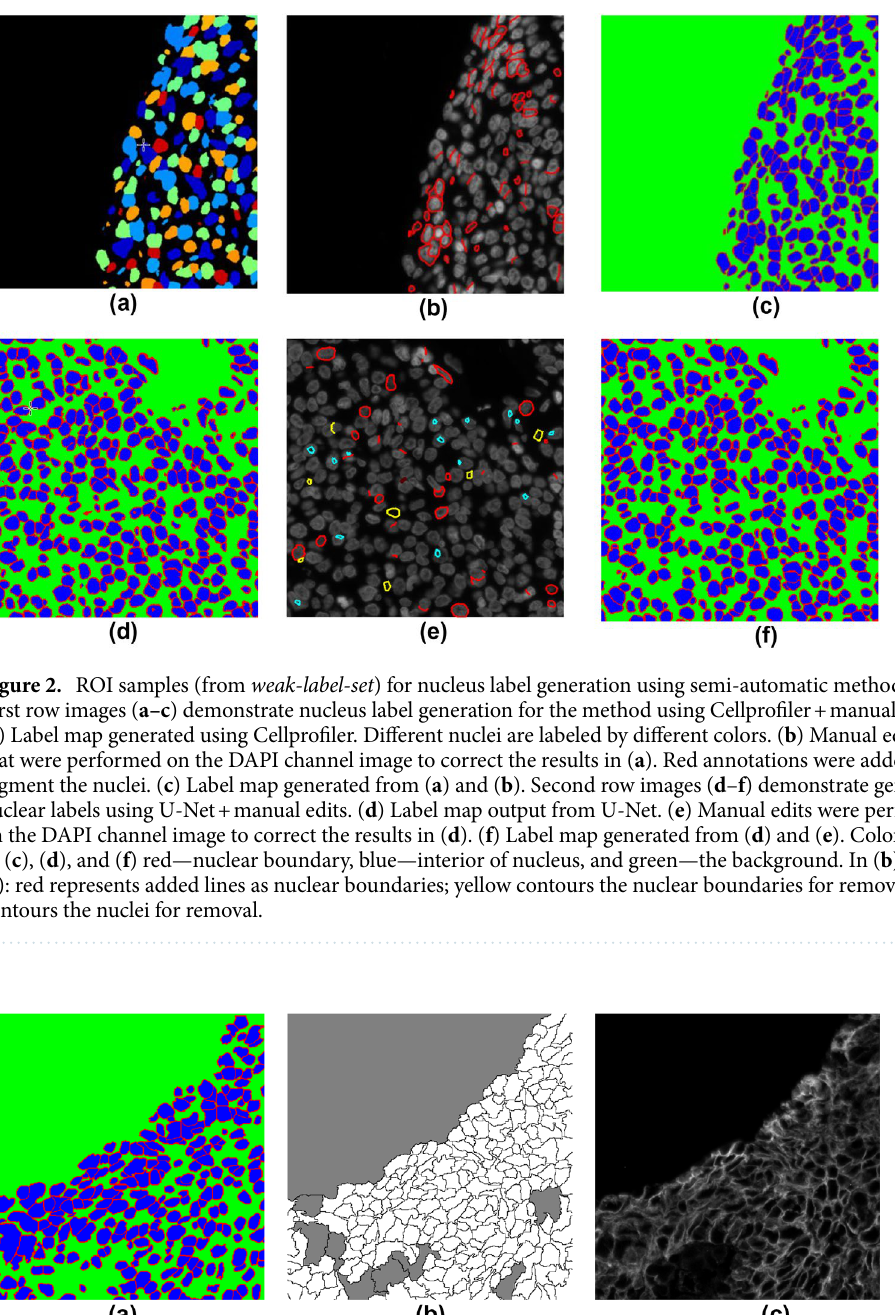
with weak-label-set ; (2) fine-tuning with manual annotated datasets. Weak cell boundary labels were generated using a semi-automatic method as described above (see steps in B and C in Fig. 1). For comparison purposes, experiments were also performed on a model without pre-training using the weakly labeled dataset ( pre-train COCO ) (see Fig. 1). In the experiment using a public dataset (see details in experiment design below), a model ( pre-train breast ) was fine-tuned from the final model trained for the breast cancer dataset. Mask R-CNN 21 is a deep learning architecture for instance segmentation (see workflow in Fig. 4). There are two stages: (1) generating the proposals for the regions where the objects might exist using a region proposal network (RPN) described by Lin et al. 33 ; (2) based on the proposals, performing classification (i.e. classifying each proposal as object labels), refining the bounding boxes of the proposal, and segmenting the object. The